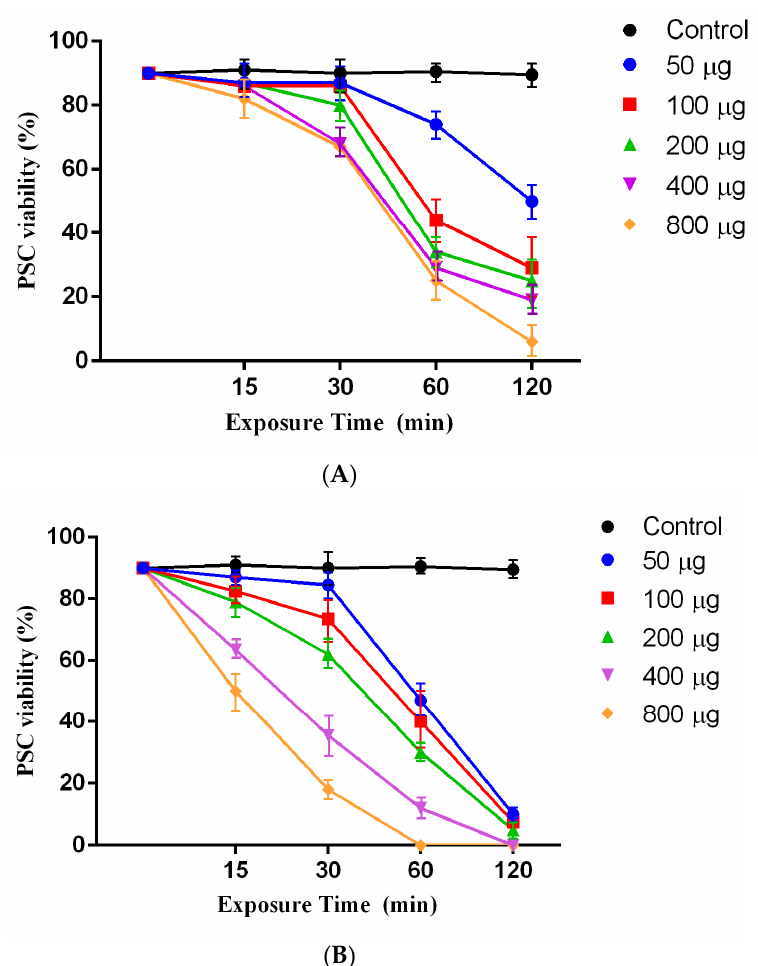
Figure 2. ( A ) Scolicidal effects of different concentrations of juglone at various times of exposure against PSCs of E. granulosus. Each test was performed in triplicate. ( B ) Scolicidal effects of different concentrations of the juglone nanoliposomesat various times of exposure against PSCs of E. granulosus . Each test was performed in triplicate.